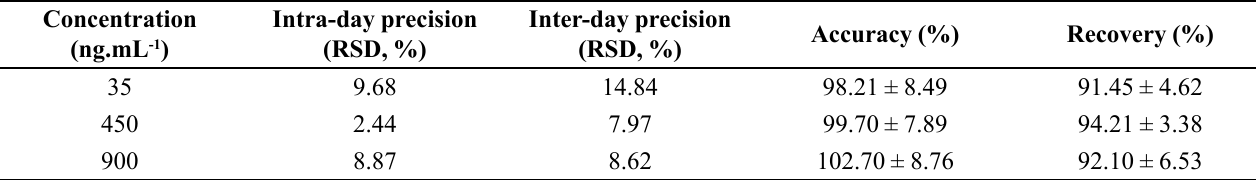
TABLE I - Intra- and inter-day precision (RSD), accuracy (mean ± SD) and relative recovery (mean ± SD) for the RH quality controls in rat plasma (n = 6)